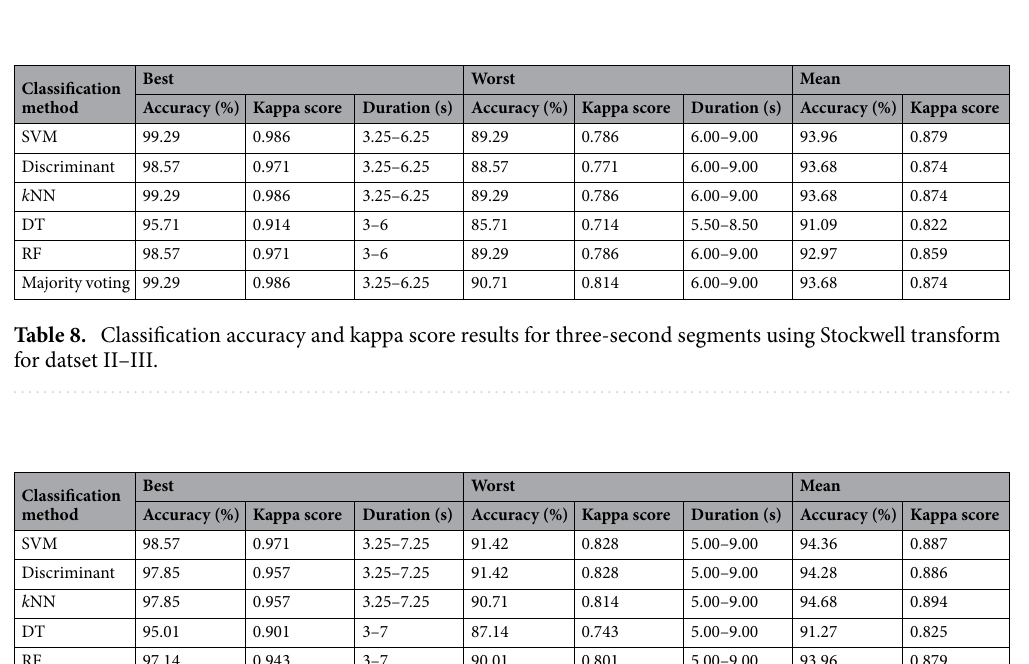
Table 9. Classification accuracy and kappa score results for four-second segments using Stockwell transform for datset II–III.